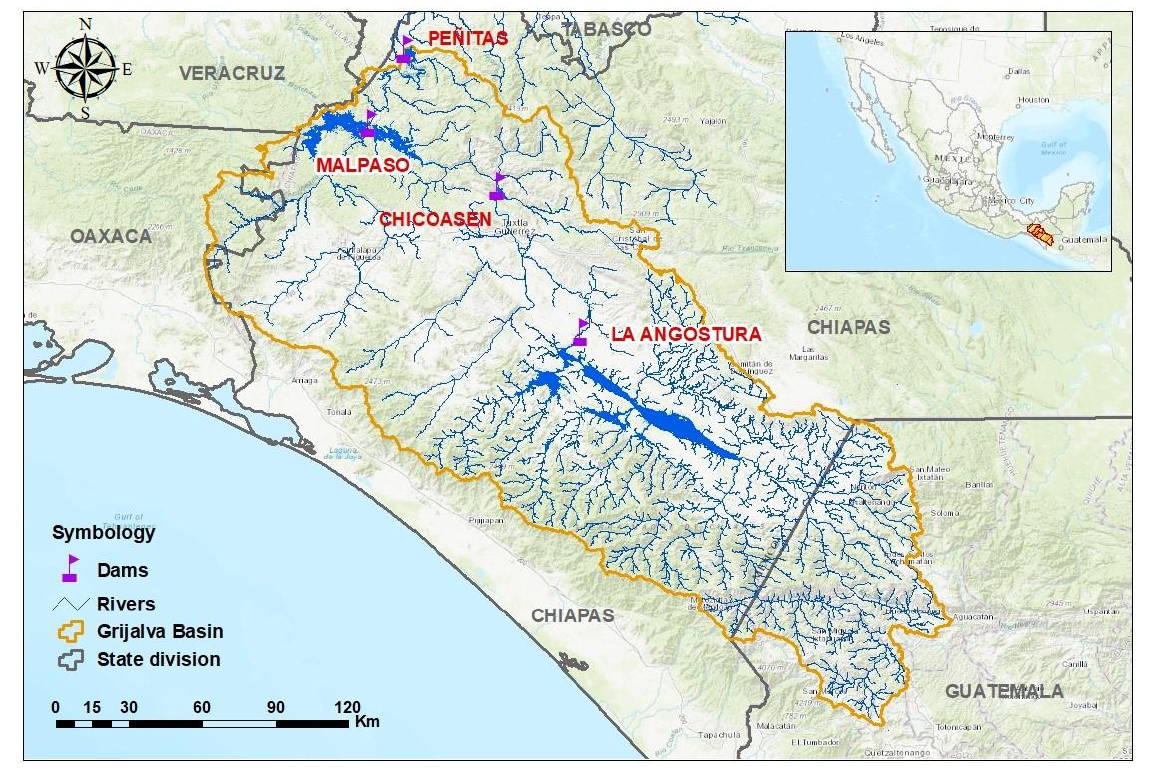
Figure 2. Grijalva River hydro-electrical system [35] .